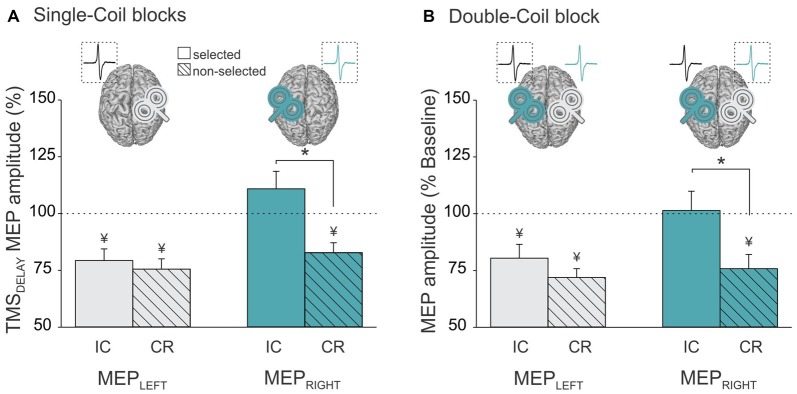
Amplitude of MEPs recorded at TMSDELAY (expressed in percentage of MEPs elicited at TMSBASELINE) in the left (MEPLeft, gray bars) and right (MEPRight, turquoise bars) FDI when this muscle was selected (open bars, reflecting impulse control (IC) inhibition) or non-selected (dashed bars, reflecting competition resolution (CR) inhibition) for the forthcoming response. Data are shown separately for (A) the Single-Coil blocks (MEPLeft and MEPRight elicited separately in the Single-CoilRM1 and Single-CoilLM1 blocks, respectively) and (B) the Double-Coil block (MEPLeft and MEPRight elicited concurrently in the same block). Data from the two groups of subjects are averaged. *Significantly different (p < 0.05). ¥Significantly different from MEPs elicited at TMSBASELINE.